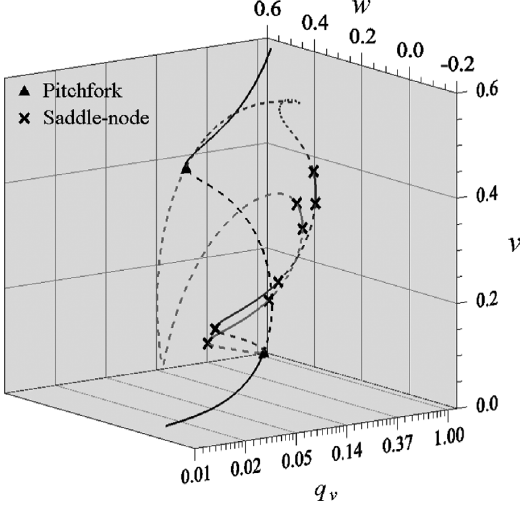
Fig. 17. Bifurcation diagram in the v − w − q v space, considering a lateral harmonic excitation at 45 ◦ . Case 0, Ω v = 3.63. associated with the bifurcation diagrams shown in Figs 15(a)–(c). Here the maximum displacement of the beam is plotted as a function of the lateral harmonic excitation magnitude. The colors used to identify the distinct solution branches are the same used in the Fig.